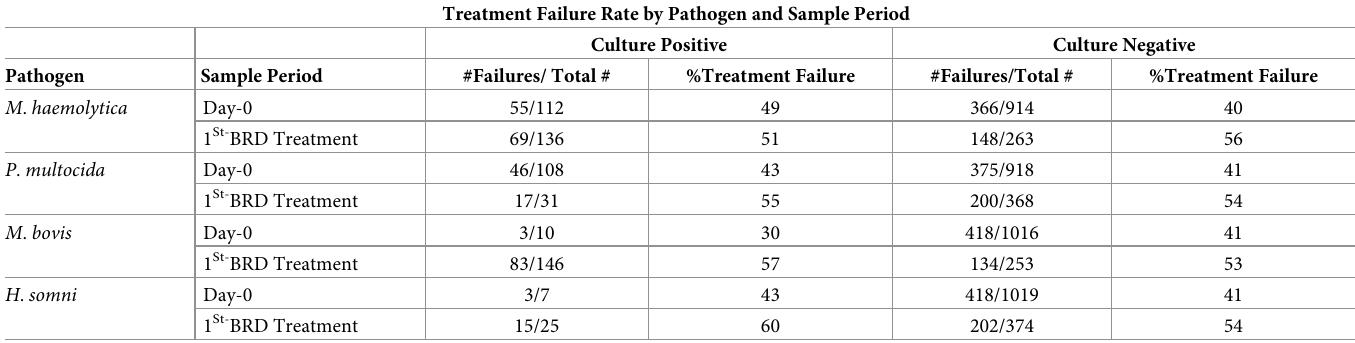
Table 2. High-risk feeder heifer treatment failure rate by culture status and timing of sample.